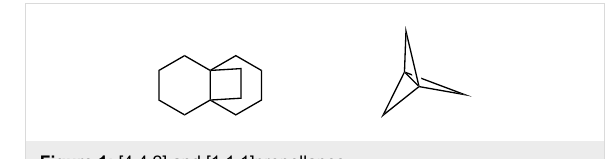
Figure 1: [4.4.2] and [1.1.1]propellanes.